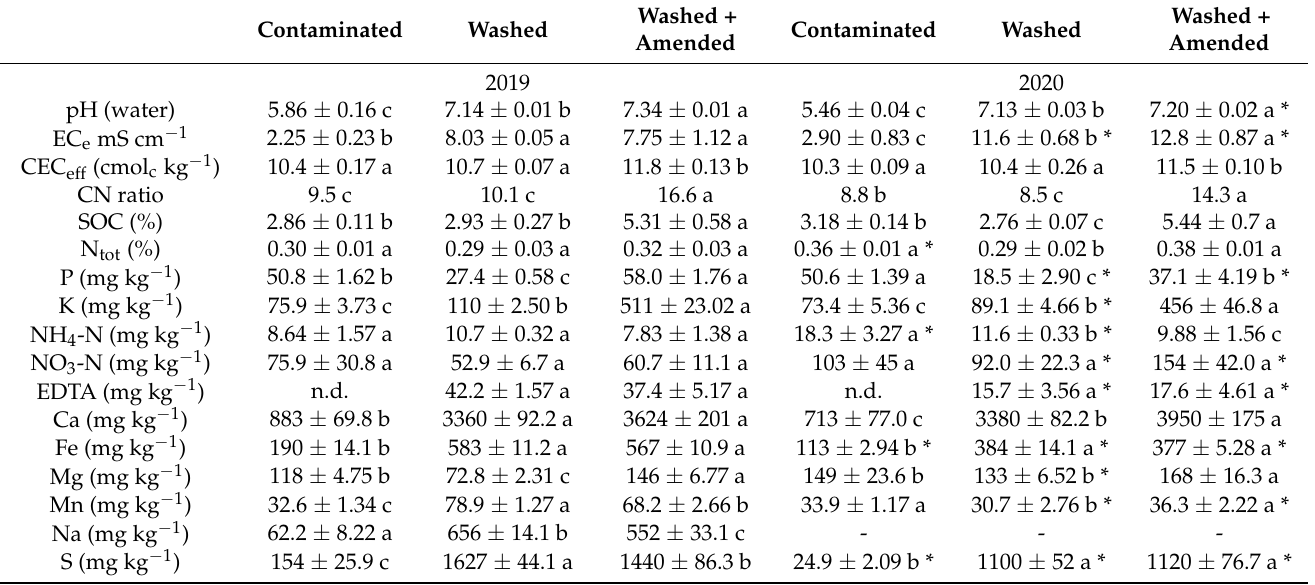
Table 1. Chemical characteristics of the soil treatments at the start of the experiment and after 7 months (mean ± SD, n = 4). Lower case letters indicate significant differences between groups of one sampling event. Asterisks indicate significant differences between 2019 and 2020 of one